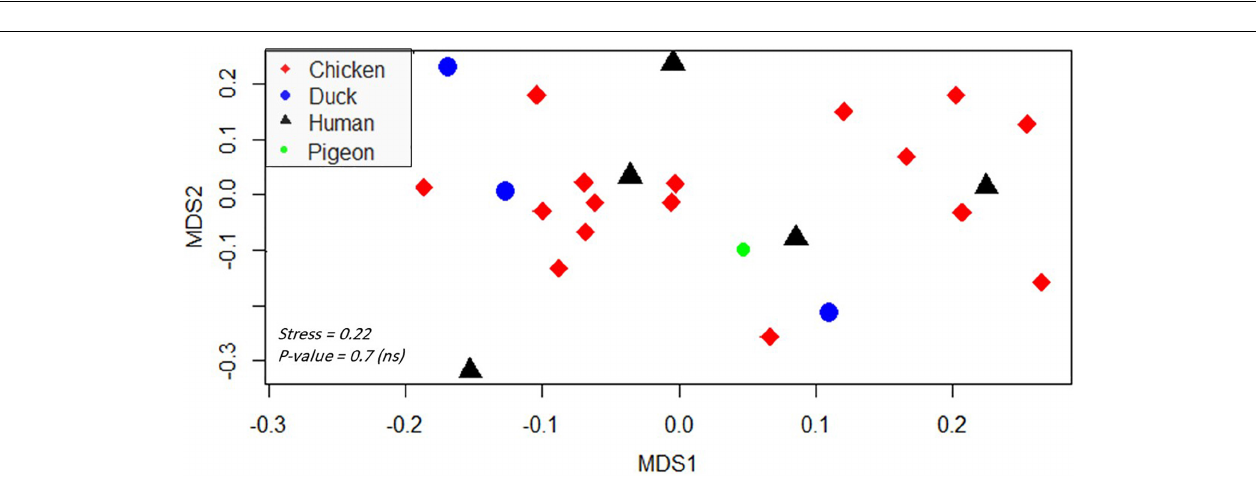
FIGURE 3 | Correlation among genetic features in the co-resistant XDR Salmonella isolates ( n = 25). Asterisks (*) indicate a significant correlation at a 0.05 p -value. The color scale refers to the correlation coefficient (blue and red colors indicate negative and positive correlations, respectively).